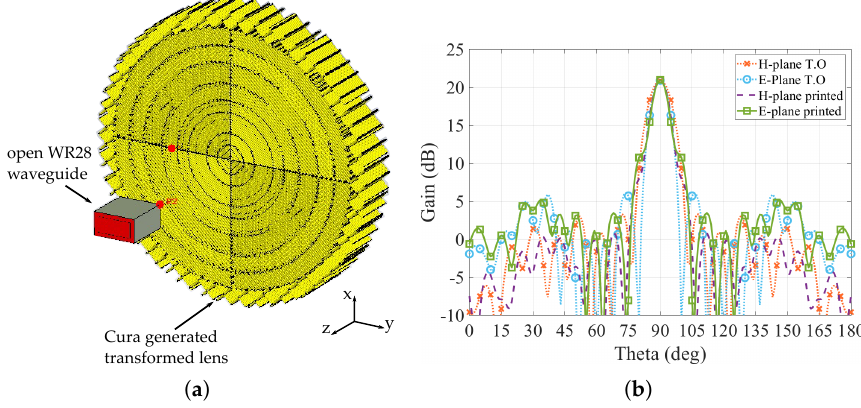
Figure 9. Cura generated 3D-printed transformed hyperbolic lens. ( a ) Simulation setup. ( b ) Gain radiation pattern of 3D-printed lens compared to the solid transformed